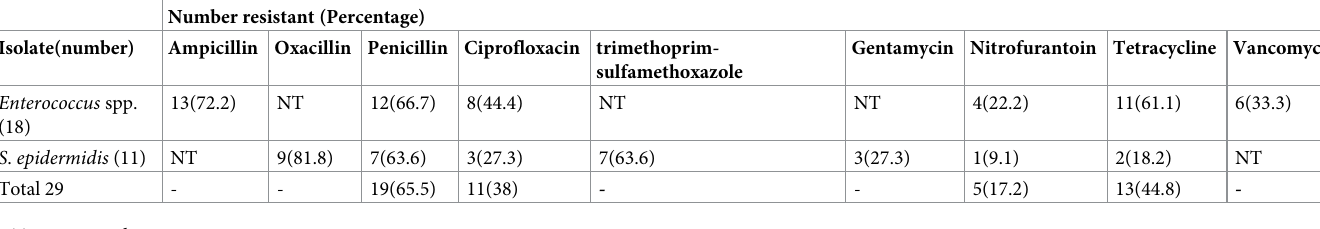
Table 5. Percentage antibiotic resistance profile of Gram-positive bacteria against ten antibiotics.